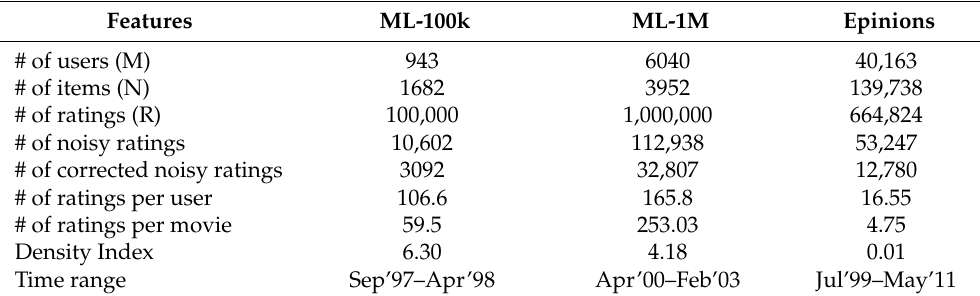
Table 9. Dataset